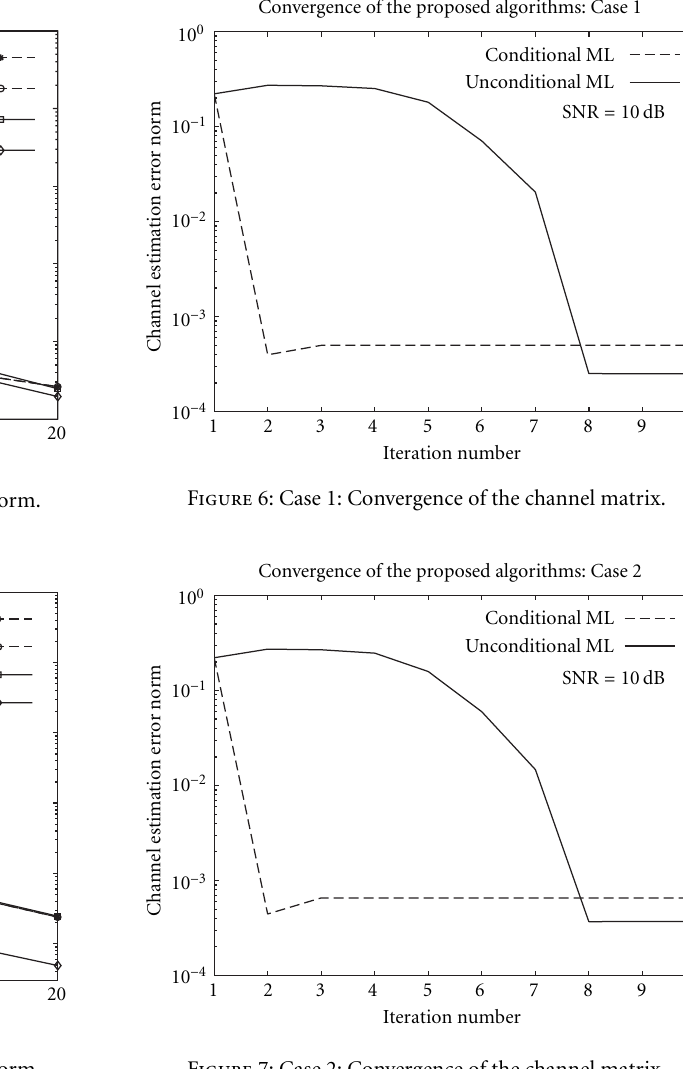
Figure 7: Case 2: Convergence of the channel